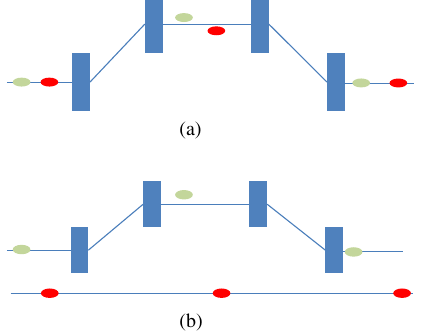
FIG. 1. A schematic layout of two different delaying methods: (a) the two bunches both go through the chicane and (b) only one of the two bunches goes through the chicane. The two bunches are assumed to have an initial time delay before the chicane.